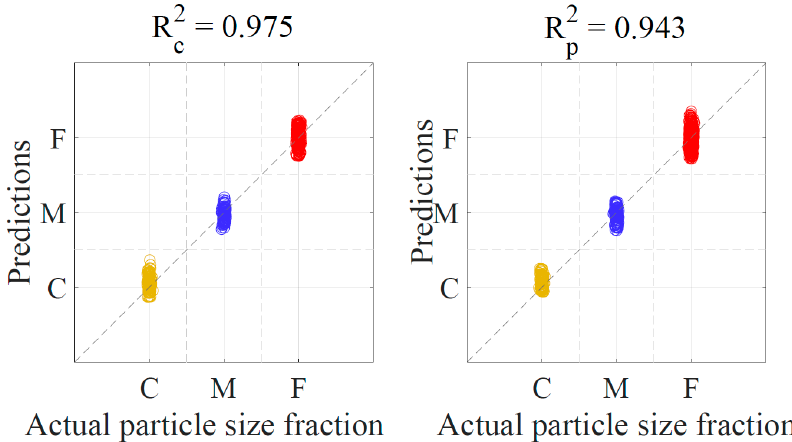
Figure 4. Prediction of milk powder samples into coarse, medium, and fine fractions.